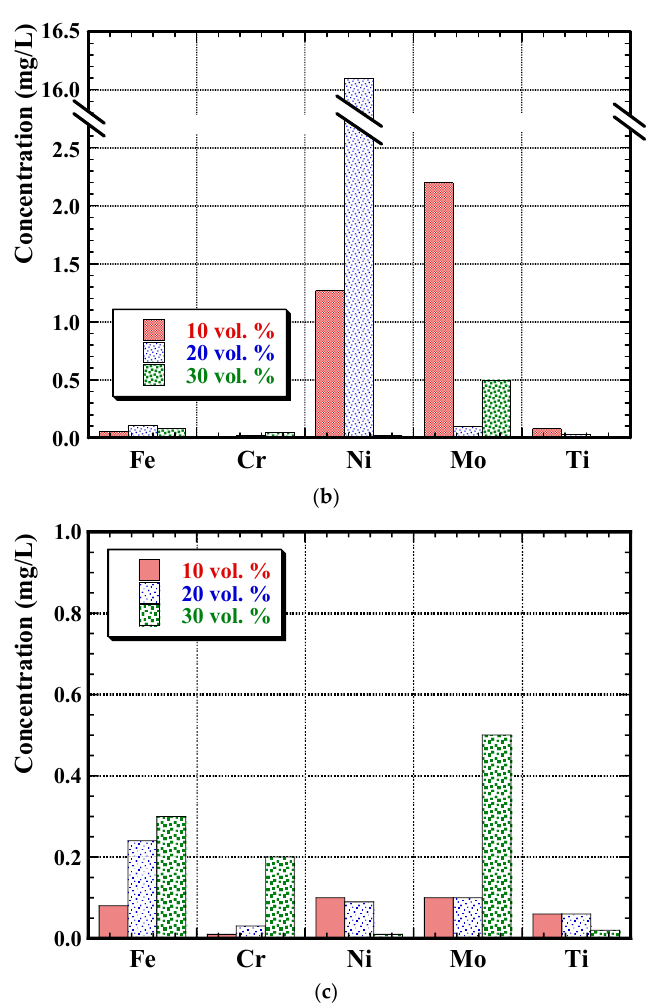
Figure 10. ICP-OES analyses of the remaining post-test solution, following filtration to remove particulate material, after corrosion testing of the TiC–stainless steel cermets: ( a ) TiC-304 L; ( b ) TiC-316 L; and ( c ) TiC-410 L.